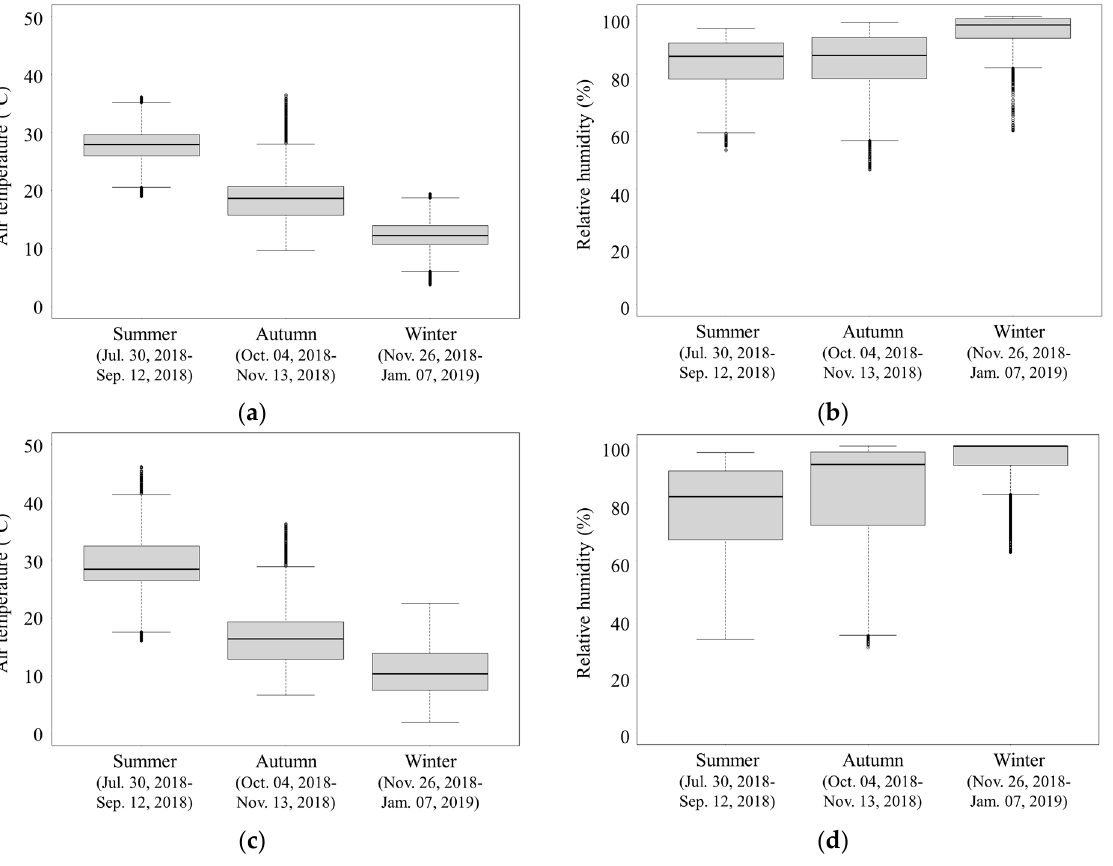
Figure 5. Box plots of the measured air temperature and relative humidity inside the duck houses according to seasons. ( a ) Air temperature inside the mechanically ventilated duck house; ( b ) relative humidity inside the mechanically ventilated duck house; ( c ) air temperature inside the naturally ventilated duck house; ( d ) relative humidity inside the naturally ventilated duck house. Table 4. Date information according to growing period during experimental period.